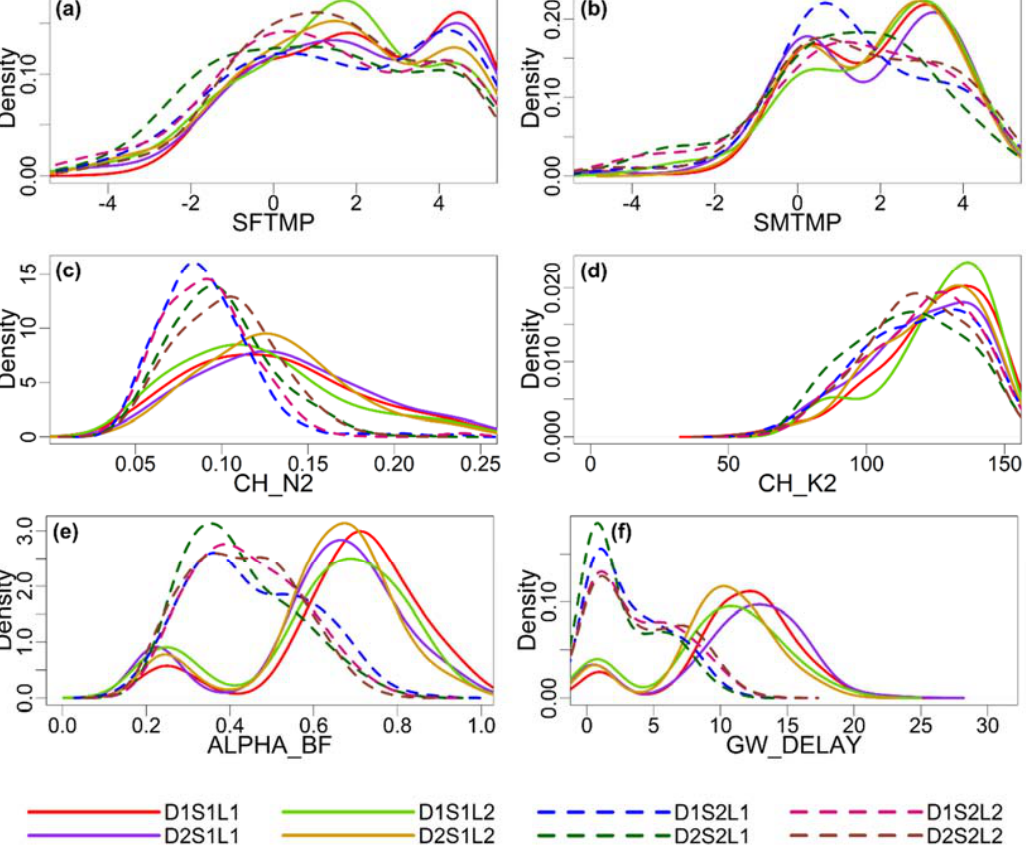
Figure 6. Density curves representing the posterior parameter distribution ( a – f ) for all tested SWAT model setups (see Table 2 for acronyms and definition of model parameters). The different model setup combinations refer to digital elevation maps (D), LULC maps (L) and soil maps (S) (see Table 1 for further description). Results are grouped by the use of a global soil map (S1) with a solid line and a regional soil map (S2) as a dashed line.